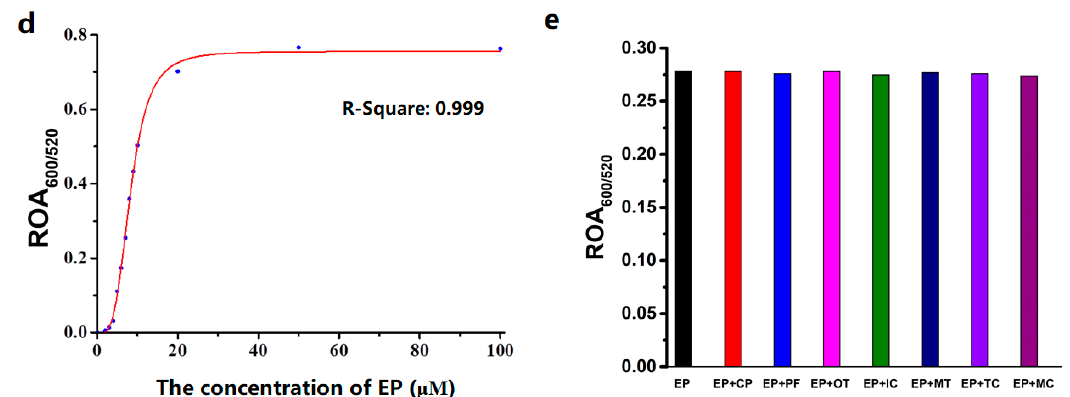
Figure 3. ( a ) The color changes of rhodamine B (RB)-AuNPs (3.0 nM) added with various pesticides (10.0 µM for ethoprophos, profenofos, and chlorpyrifos; 1.0 mM for others). ( b ) The Δ A 520 values changes of RB-AuNPs (3.0 nM) added with various OP pesticides (10.0 µM for ethoprophos, profenofos, and chlorpyrifos; 1.0 mM for others). ( c ) The absorption spectra changes and ( d ) corresponding fitting curve plot of RB-AuNPs (3.0 nM) in the presence of different concentrations of ethoprophos. ( e ) Selectivity studies of RB-AuNPs by measuring ROA 600/520 versus interference analytes with a specific concentration.